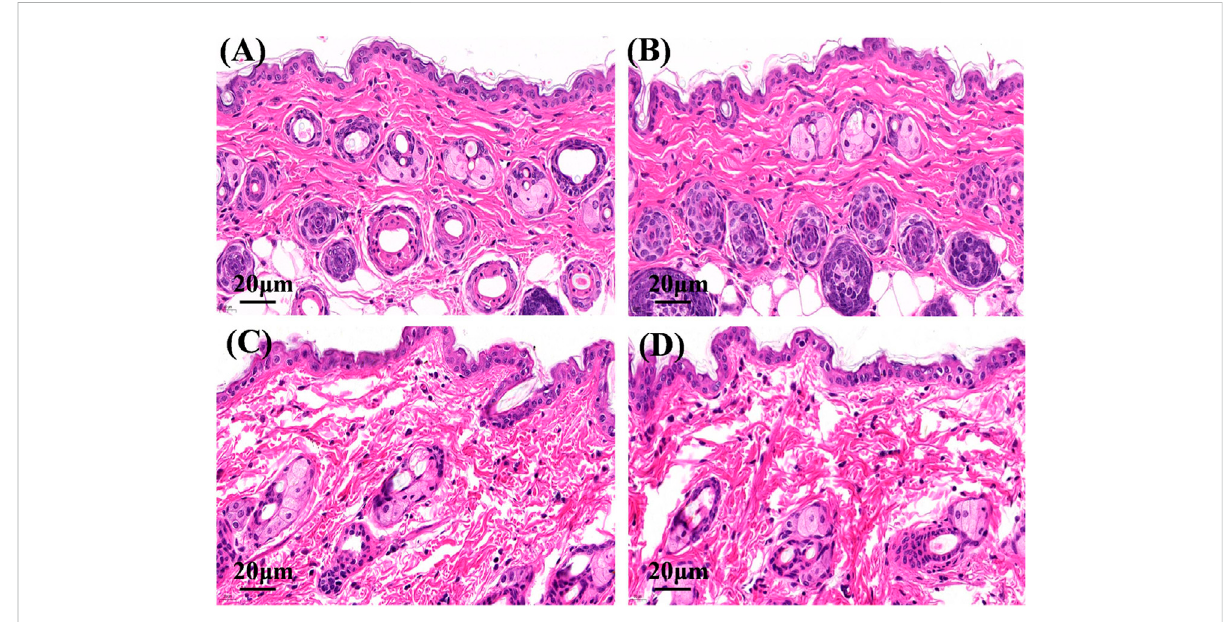
FIGURE 6 Micrographsofhematoxylinandeosinstainedmiceskinsectionsafterthemiceweretreatedwithphysiologicalsaline (A) ,Cursolution (B) ,Cur- HNGs (C) , and Cur-SHNGs (D) ( n =